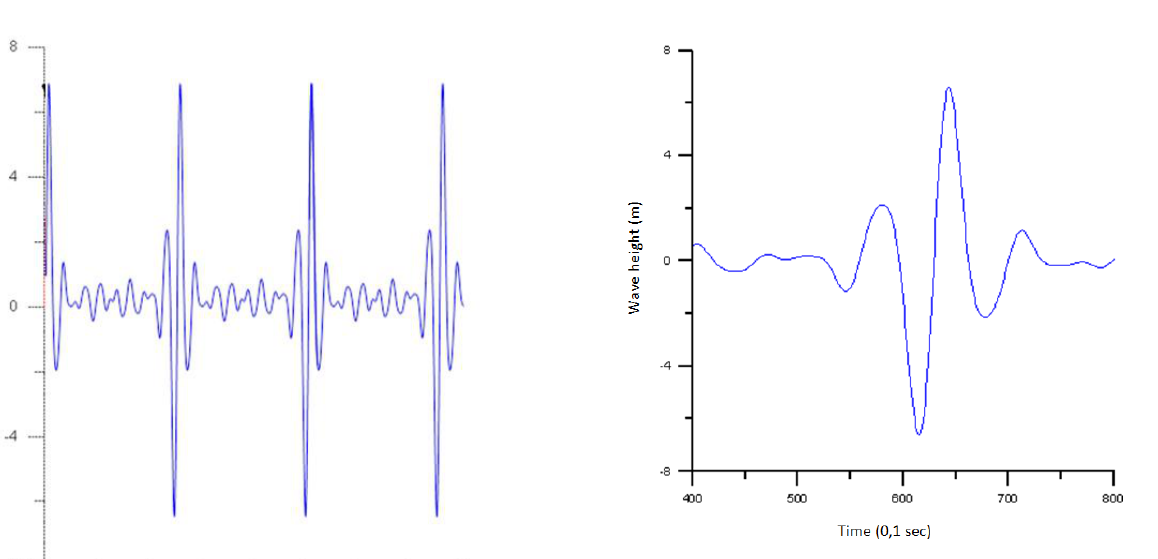
Fig. 6. Maximum wave height. One big wave accompanied by two smaller